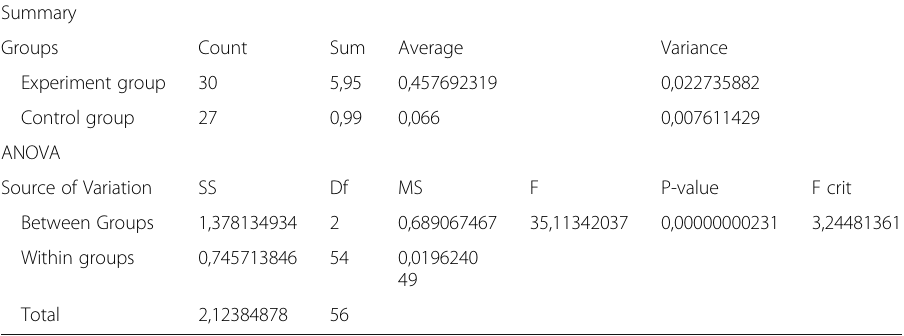
Table 4 ANOVA test outputs: single factor Summary Groups Count Sum Variance